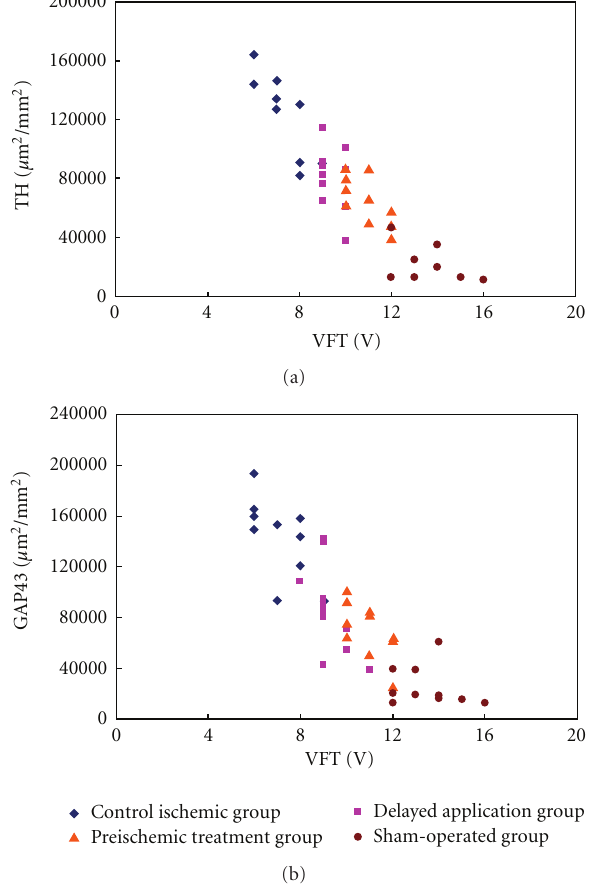
Figure 5: Graph of linear correlation analysis between VFT and TH- (a) or GAP43- (b) positive nerve fiber density.